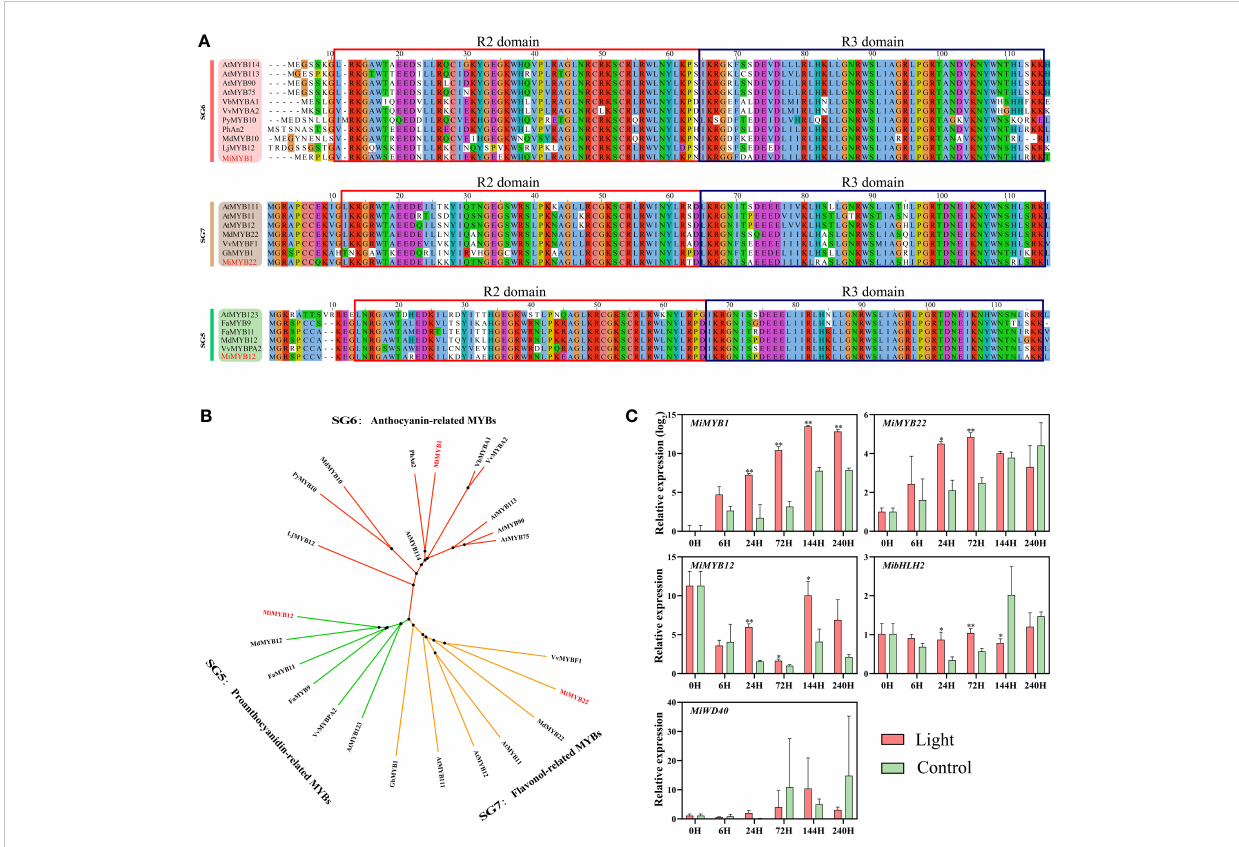
FIGURE 4 (A) Multiple sequence alignment of fl avonoids-related MYBs in mango and other plant species. The R2R3 domain is boxed. The mango proteins are highlighted in red. (B) Phylogenetic tree derived from amino acid sequences of fl avonoids-related MYBs in mango and other plant species. The mango proteins are highlighted in red. All sequences were retrieved from NCBI database with accessions as follows: SG6: Arabidopsis thaliana AtMYB114 (Q9FNV8.1), AtMYB113 (Q9FNV9.1), AtMYB90 (Q9ZTC3.1) and AtMYB75 (Q9FE25.1); Vitis betulifolia VbMYBA1 (AGH68552.1); Vitis vinifera VvMYBA2 (BAD18978.1); Pyrus pyrifolia PyMYB10 (ALN66630); Petunia x hybrida PhAN2 (AAF66727); Malus domestica MdMYB10 (ACQ45201.1); Lilium japonicum var. Abeanum LjMYB12 (BAP00661.1). SG7: Arabidopsis thaliana AtMYB111 (NP_199744.1), AtMYB11 (Q9LZK4.1) and AtMYB12 (NP_182268.1); Malus